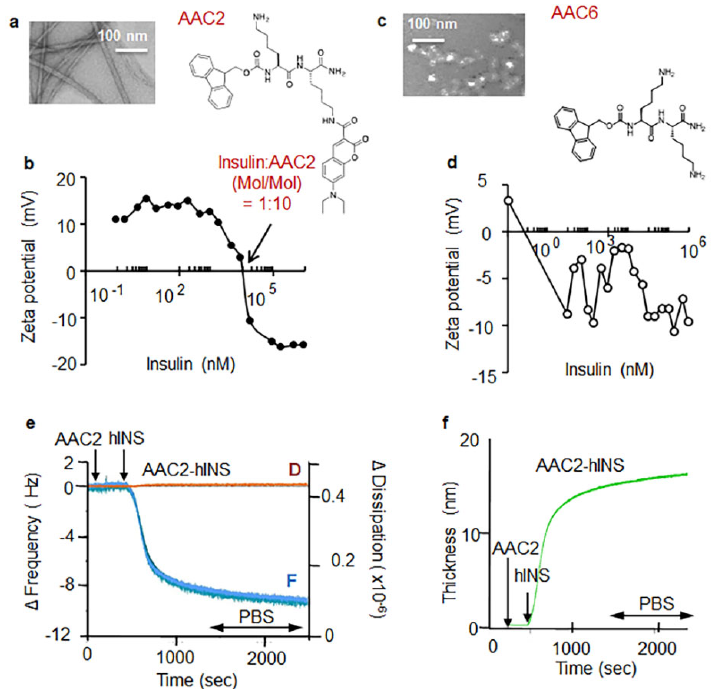
Figure 1. AAC2 is self-assembled into a positively charged nanofiber, which electrostatically bound insulin. ( a , c ) The morphology (TEM at 225,000 magnification) and chemical structure of AAC2 ( b , d ) Electrostatic interaction between AAC2 (0.1 mM in PBS) ( b ) or AAC6 ( d ) and negatively charged hINS measured as changes in Zeta potential (mV). 1:10 hINS:AAC2 (mol/mol) indicated 0 mV. ( e ) Binding kinetics of AAC2 (0.1 μ M in PBS) and hINS (10 μ g/mL in PBS) onto the active gold sensor was measured as changes in frequency (F, blue line) and dissipation (D, orange line) of the acoustic wave using quartz crystal microbalance (QCM). AAC2-hINS film was stable during PBS wash (arrow). ( f ) The thickness of AAC2-hINS film (15 nm) was calculated based on F and D kinetics. AAC2 (1 mM), FITC-INS, and a 10:1 mixture of AAC2:FITC-INS were imaged